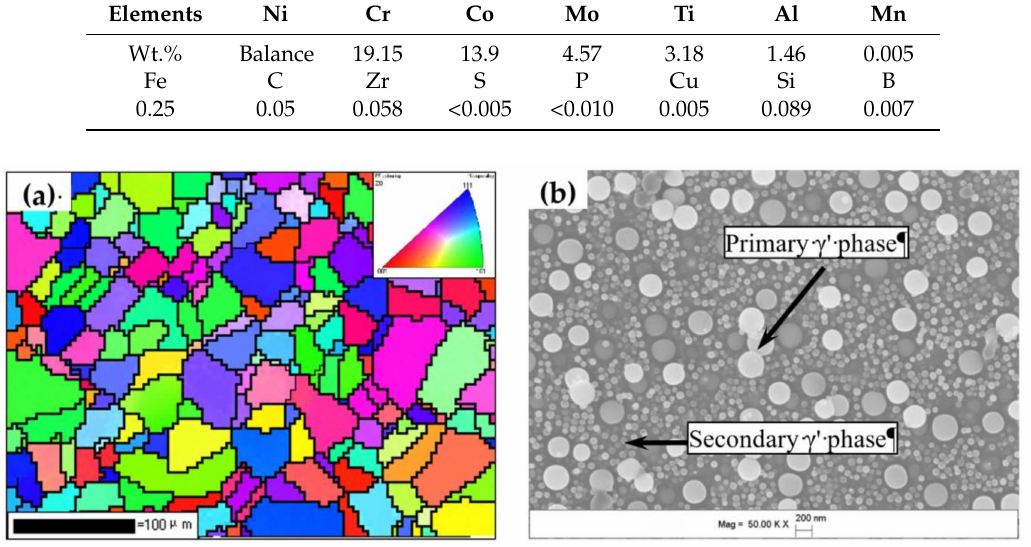
Figure 1. The initial microstructure of the specimens ( a ) EBSD (Electron Backscattered Diffraction), ( b )